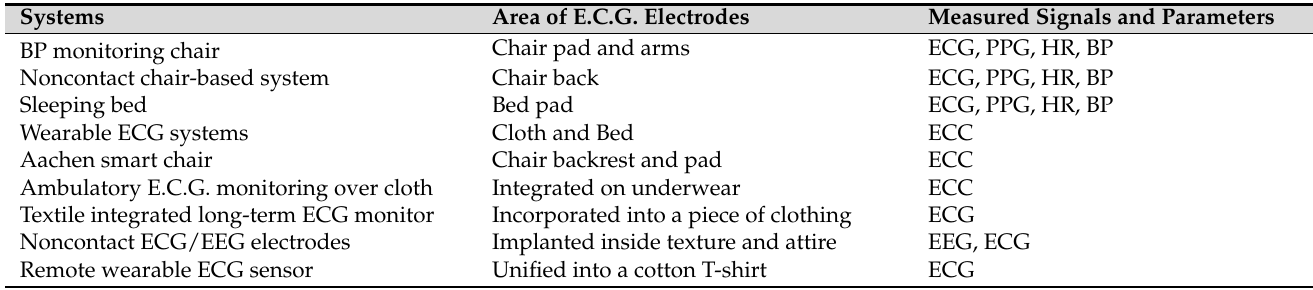
Table 1. Various usage of capacitive E.C.G. sensors.